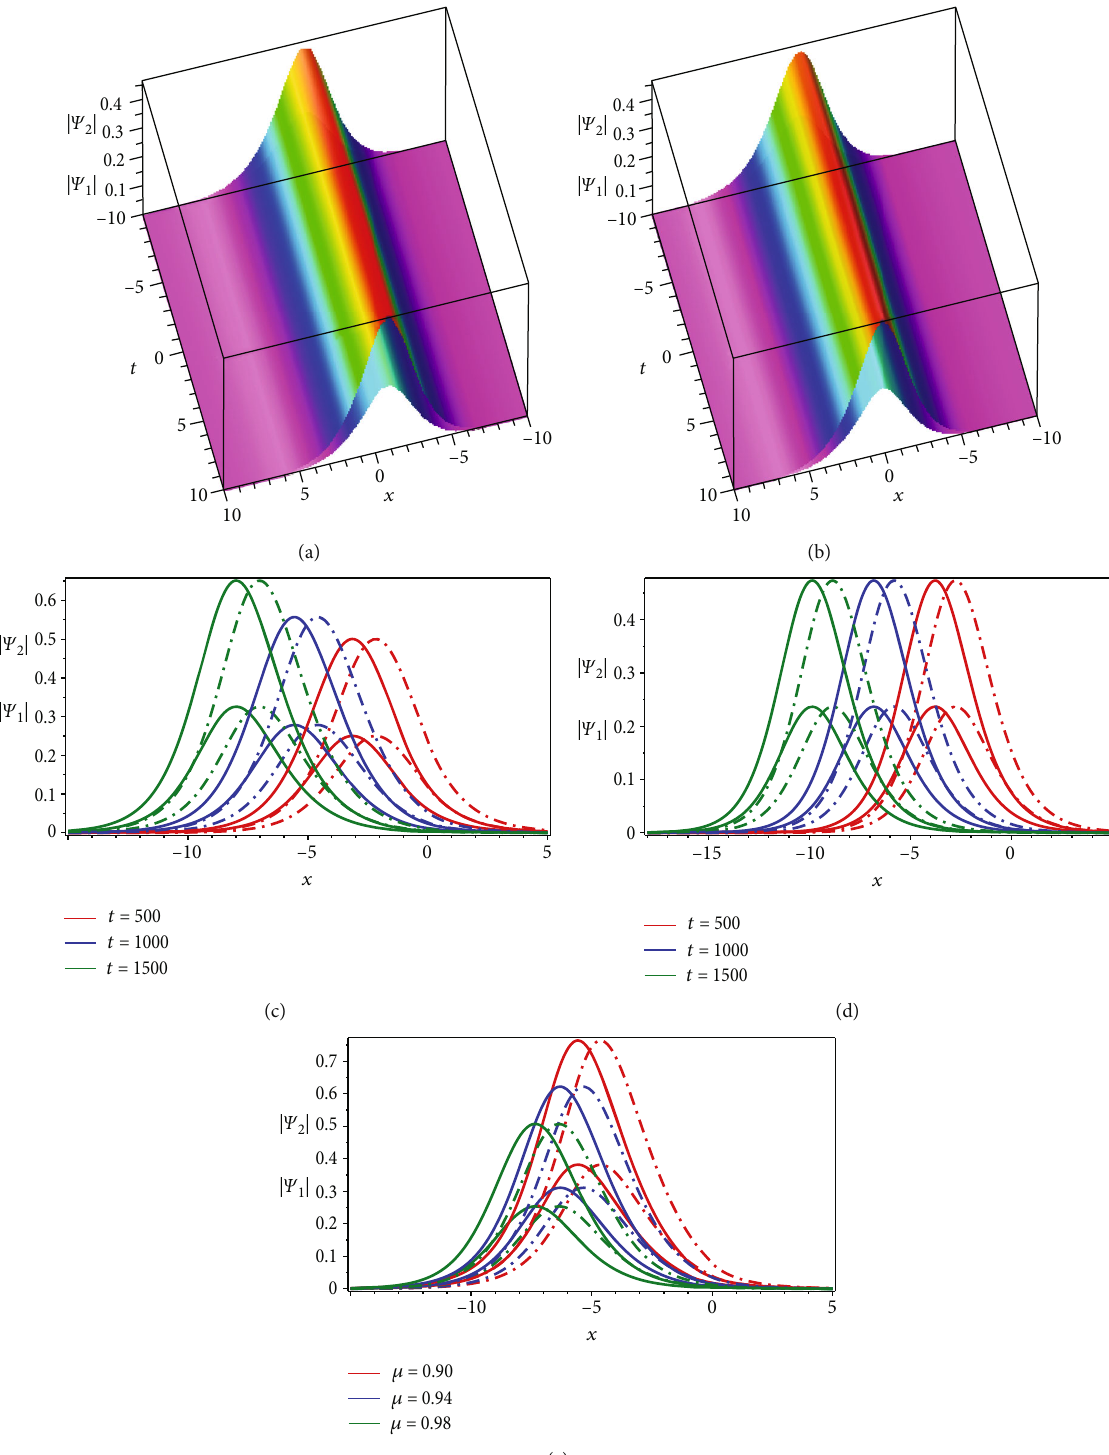
x , t Þj and j Ψ x , t Þj as in Equation (40) and Equation (41), respectively, for (a) BFD Figure 4: Optical bright soliton pro fi les of j Ψ 1 ð 2 ð parameter μ = 0 : 95 , (b) CFD parameter μ = 0 : 95 , the e ff ect (Solid line =BFD; Dash Line =CFD) of time for (c) μ = 0 : 95 and (d) μ = 1 , (e) the e ff ect of fractional parameter for t = 1200 . The remaining parameters are α = 0 : 1 , λ = 0 : 9 , σ = 0 : 5 , A = e , M = N = 1 , κ = 0 : 1 , Π = 2 , = 0 : 2 , r = − 0 : 2 , s = 0 : 3 , and θ = 1 p 1 1 0 1